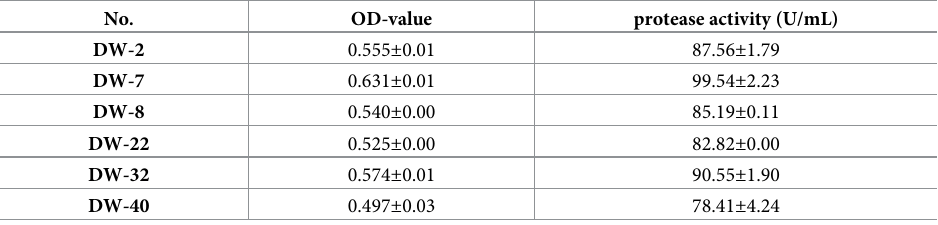
Table 2. Determination of protease